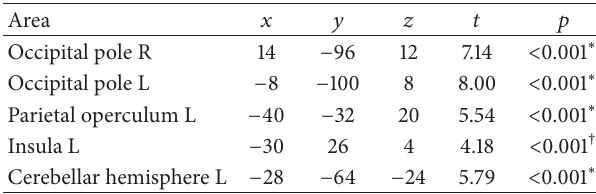
Table 4: Peak coordinates ( 𝑥,𝑦,𝑧 ), 𝑡 -statistics, and uncorrected 𝑝 values for significant brain activations during the anticipation of severe versus mild